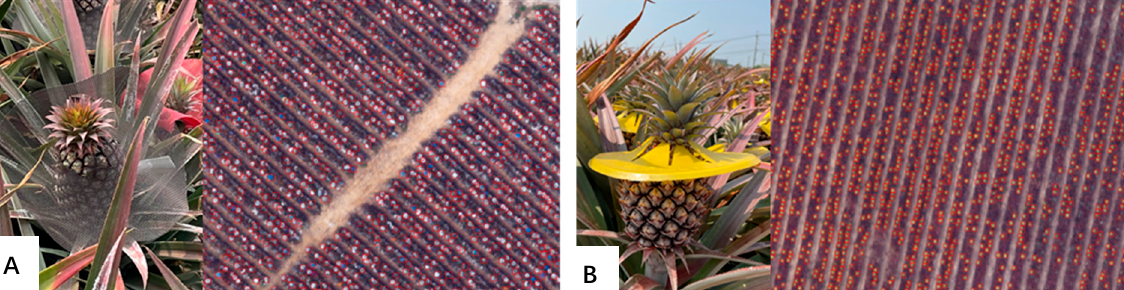
Figure 7. The in situ photos and sample set of selected plastic sheets of different colors ( A ) and yellow plastic covers ( B ).